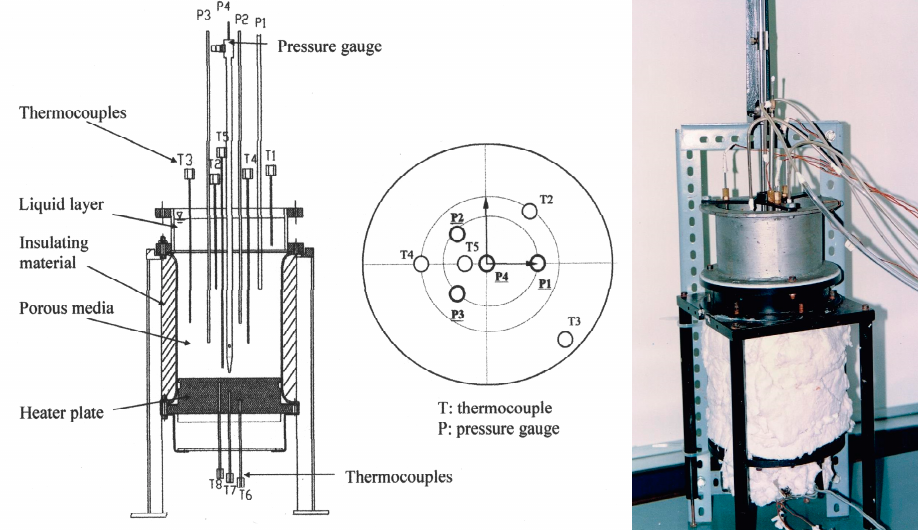
Figure 2. Scheme and photography of the boiling cell and radial position of the instrumentation.